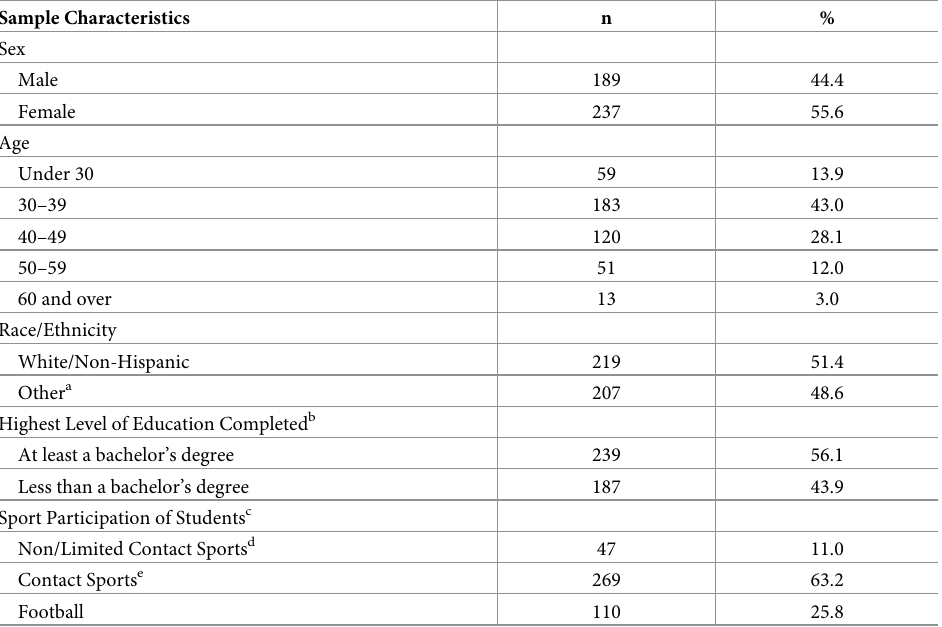
Table 1. Descriptive profile of parents of middle school students (n =